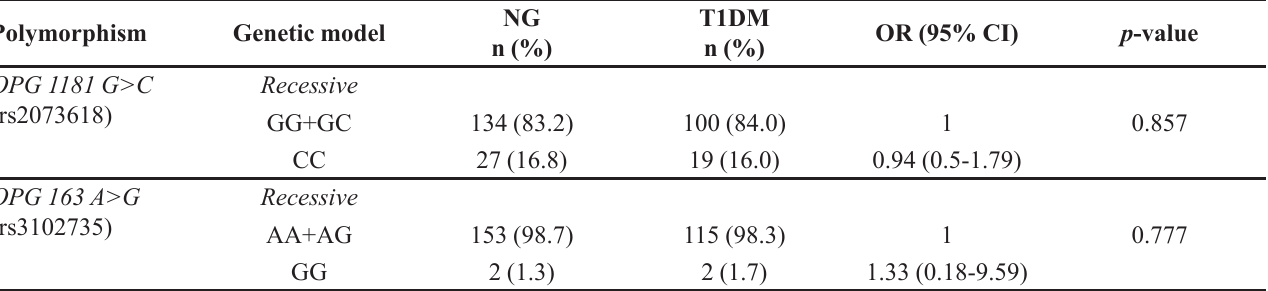
TABLE III - Genotype distribution of polymorphisms in the studied groups according to genetic models Polymorphism